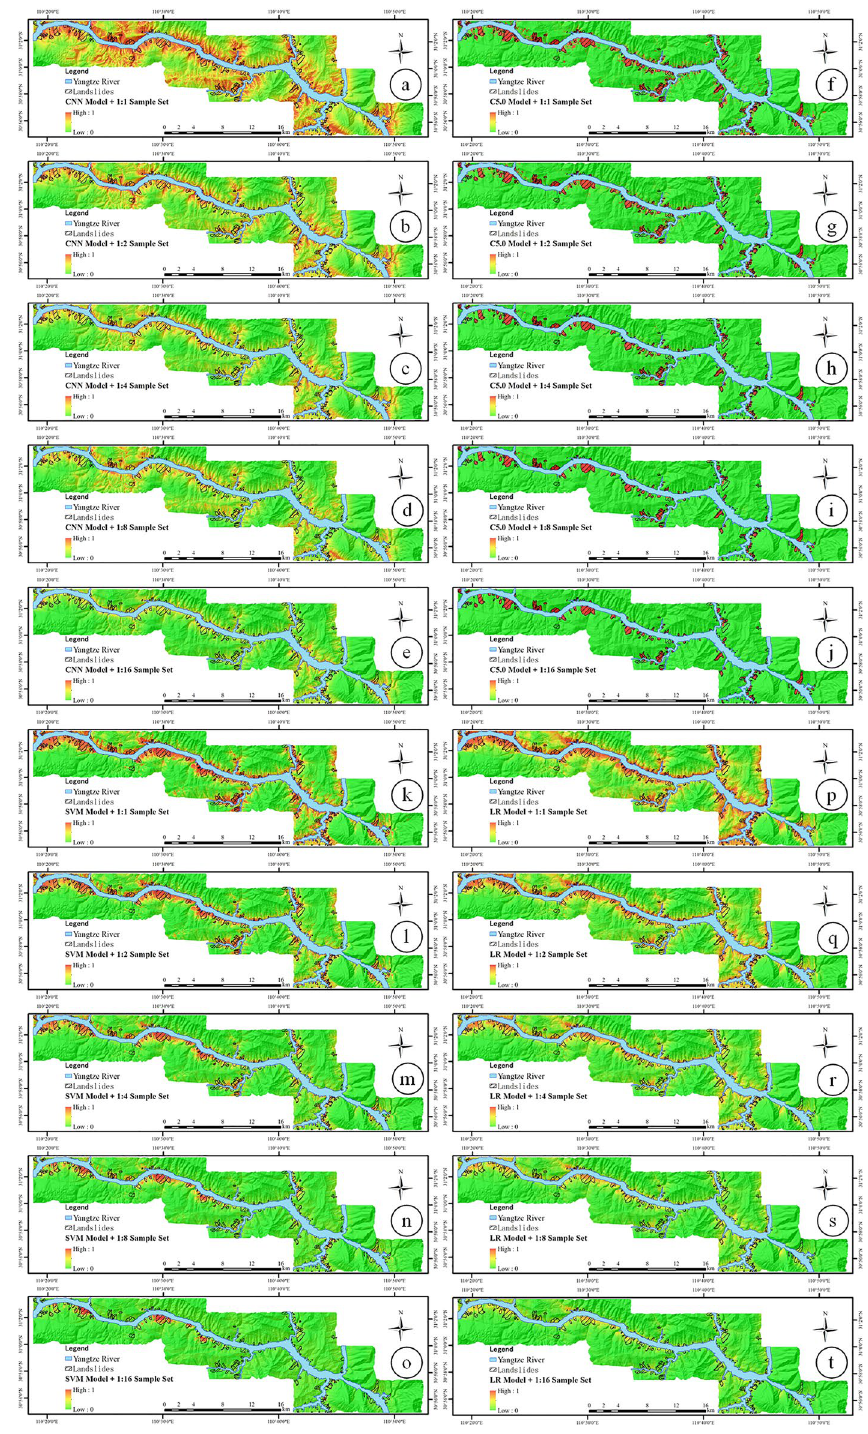
Figure 10. LSI based on ( a ) 1:1 sample set by CNN model, ( b ) 1:2 sample set by CNN model, ( c ) 1:4 sample set by CNN model, ( d ) 1:8 sample set by CNN model, ( e ) 1:16 sample set by CNN model, ( f ) 1:1 sample set by C5.0 model, ( g ) 1:2 sample set by C5.0 model, ( h ) 1:4 sample set by C5.0 model, ( i ) 1:8 sample set by C5.0 model, ( j ) 1:16 sample set by C5.0 model, ( k ) 1:1 sample set by SVM model, ( l ) 1:2 sample set by SVM model, ( m )